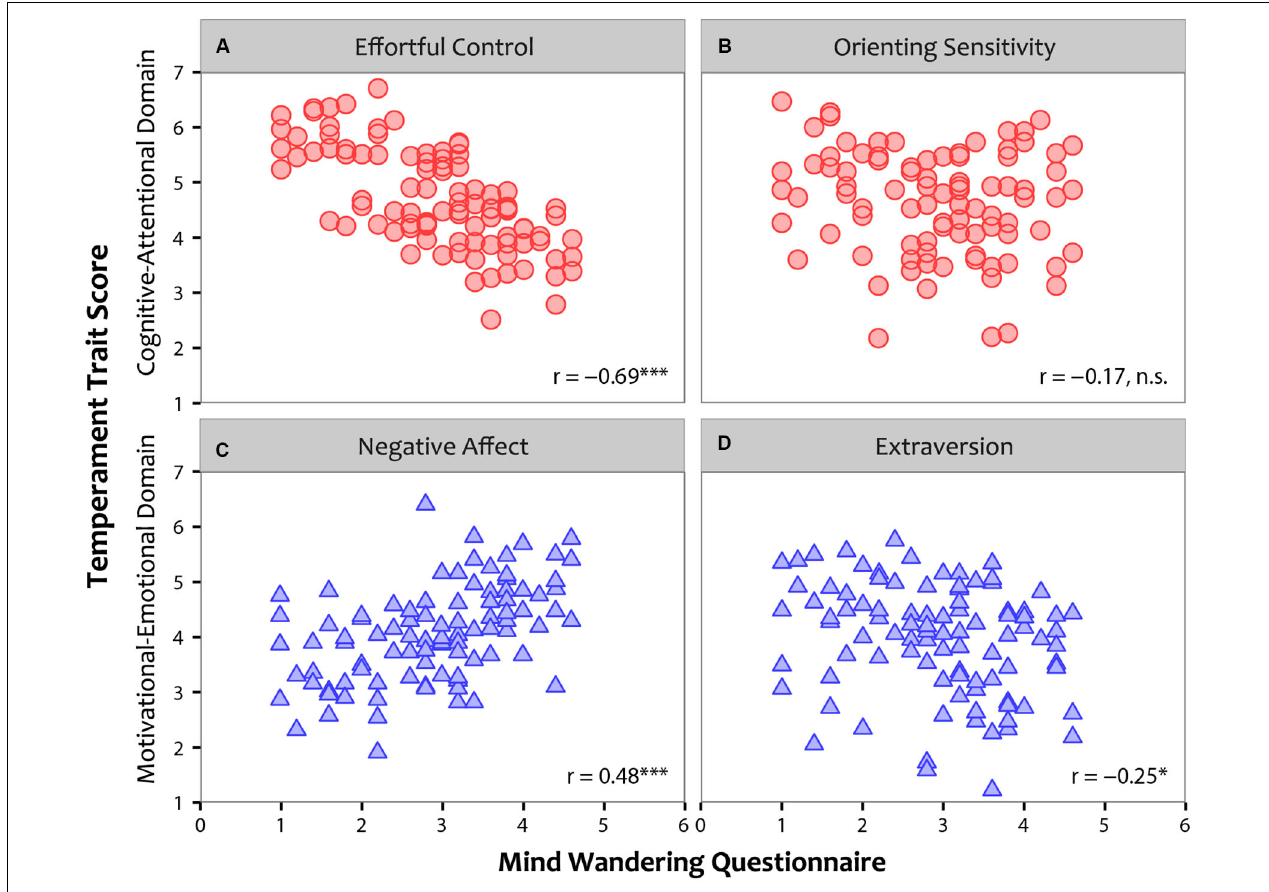
FIGURE 2 | The relationship between individual participants’ scores on the Mind Wandering Questionnaire (MWQ; x-axis) and their temperament traits as assessed by the Adult Temperament Questionnaire (ATQ; y-axis). Cognitive-Attentional axes are depicted as red circles and Motivational-Emotional axes as blue triangles. Significant relationships are indicated as follows: * p < 0.05; ** p < 0.01; *** p <